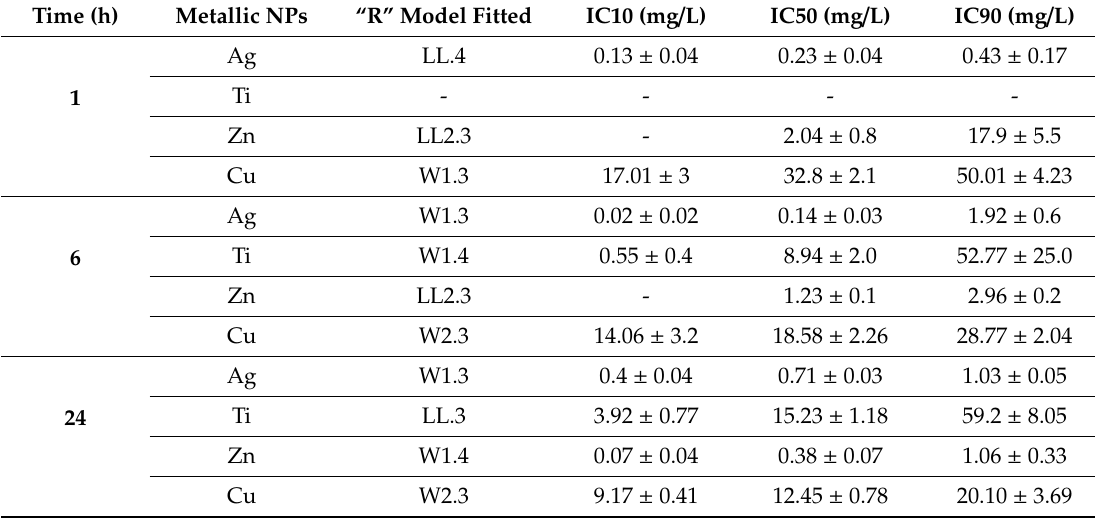
Table 3. Inhibitory concentrations of metallic NPs that induced 10%, 50% and 90% of inhibition of bioluminescence of Nostoc sp. CPB4337 growth after 1, 6, and 24 h of exposure and the “R” model type